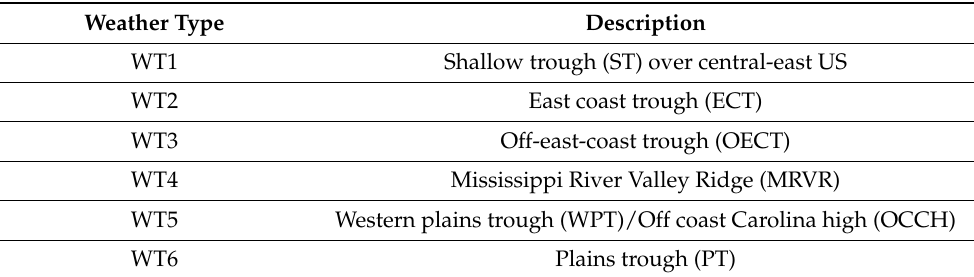
Table 1. Six weather types in the winter and their 850 hPa flow patterns.